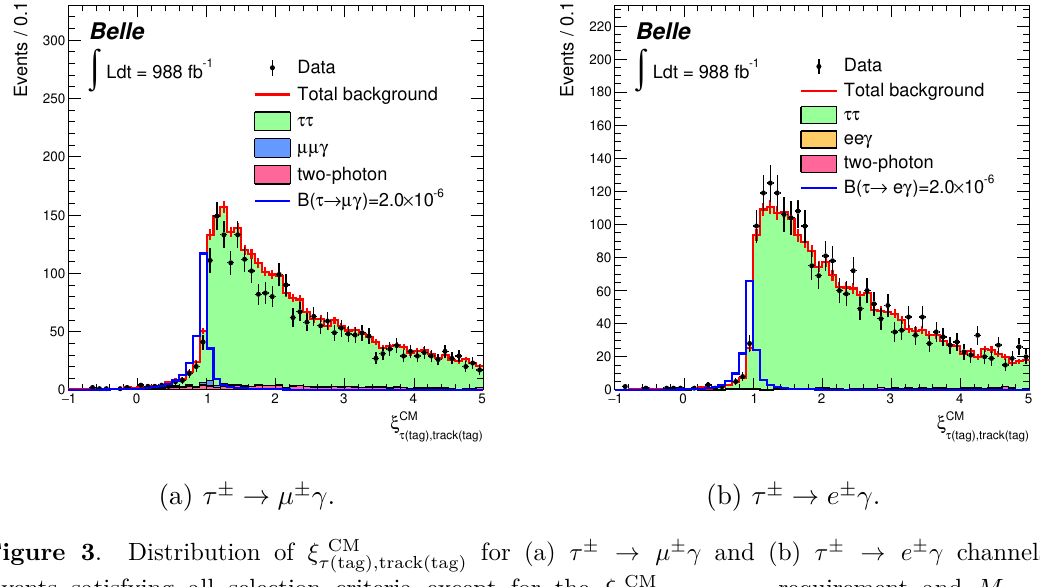
(b) τ ± → e ± γ . Figure 3 . Distribution of ξ CM for (a) τ ± → µ ± γ and (b) τ ± → e ± γ channels. τ (tag) , track(tag) Events satisfying all selection criteria except for the ξ CM requirement and M bc ∈ τ (tag) , track(tag) [1 . 73 , 1 . 85] GeV/ c 2 are plotted. The background MC samples are normalized to the cross sec- tion times integrated luminosity of 988 fb − 1 . The blue histograms show the signal MC samples with an assumed branching fractions B ( τ ± → ‘ ± γ ) = 2 . 0 × 10 − 6